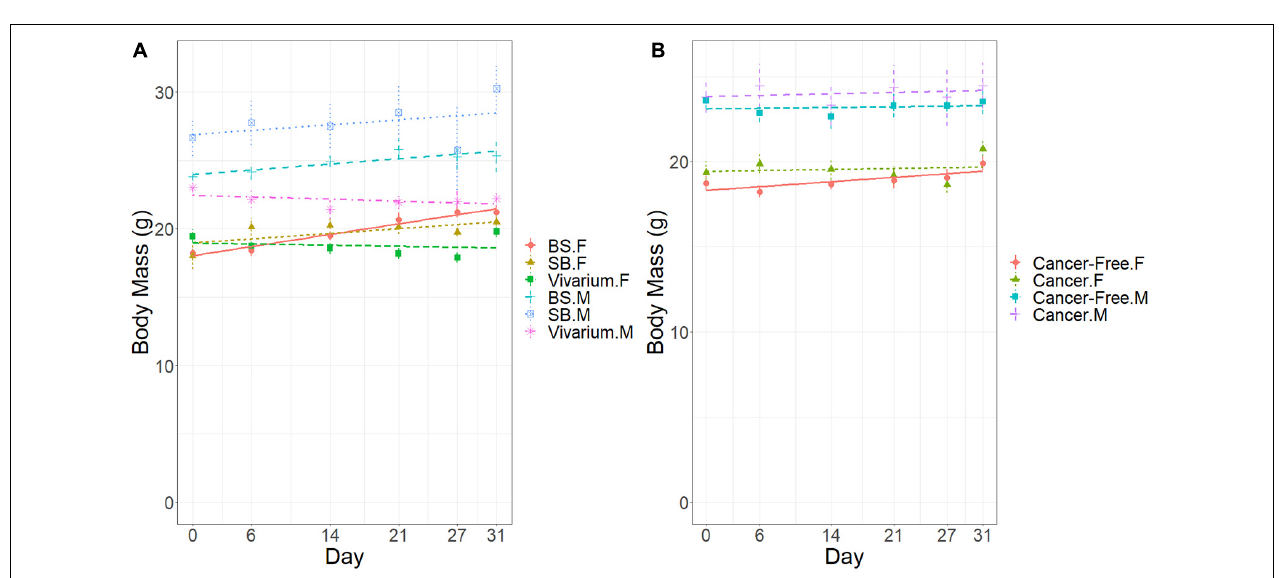
FIGURE 4 | Tumor size (cm 3 ) in the vivarium experiment and concurrent laboratory experiment over time (days). (A) Effect of sex (F, female; M, male). (B) Effect of Location (BS laboratory, laboratory in Beer Sheva with SPF conditions; SB laboratory, laboratory in Sede Boker; Vivarium, large, outdoor vivarium in Sede Boker). Error bars represent standard errors of the means.